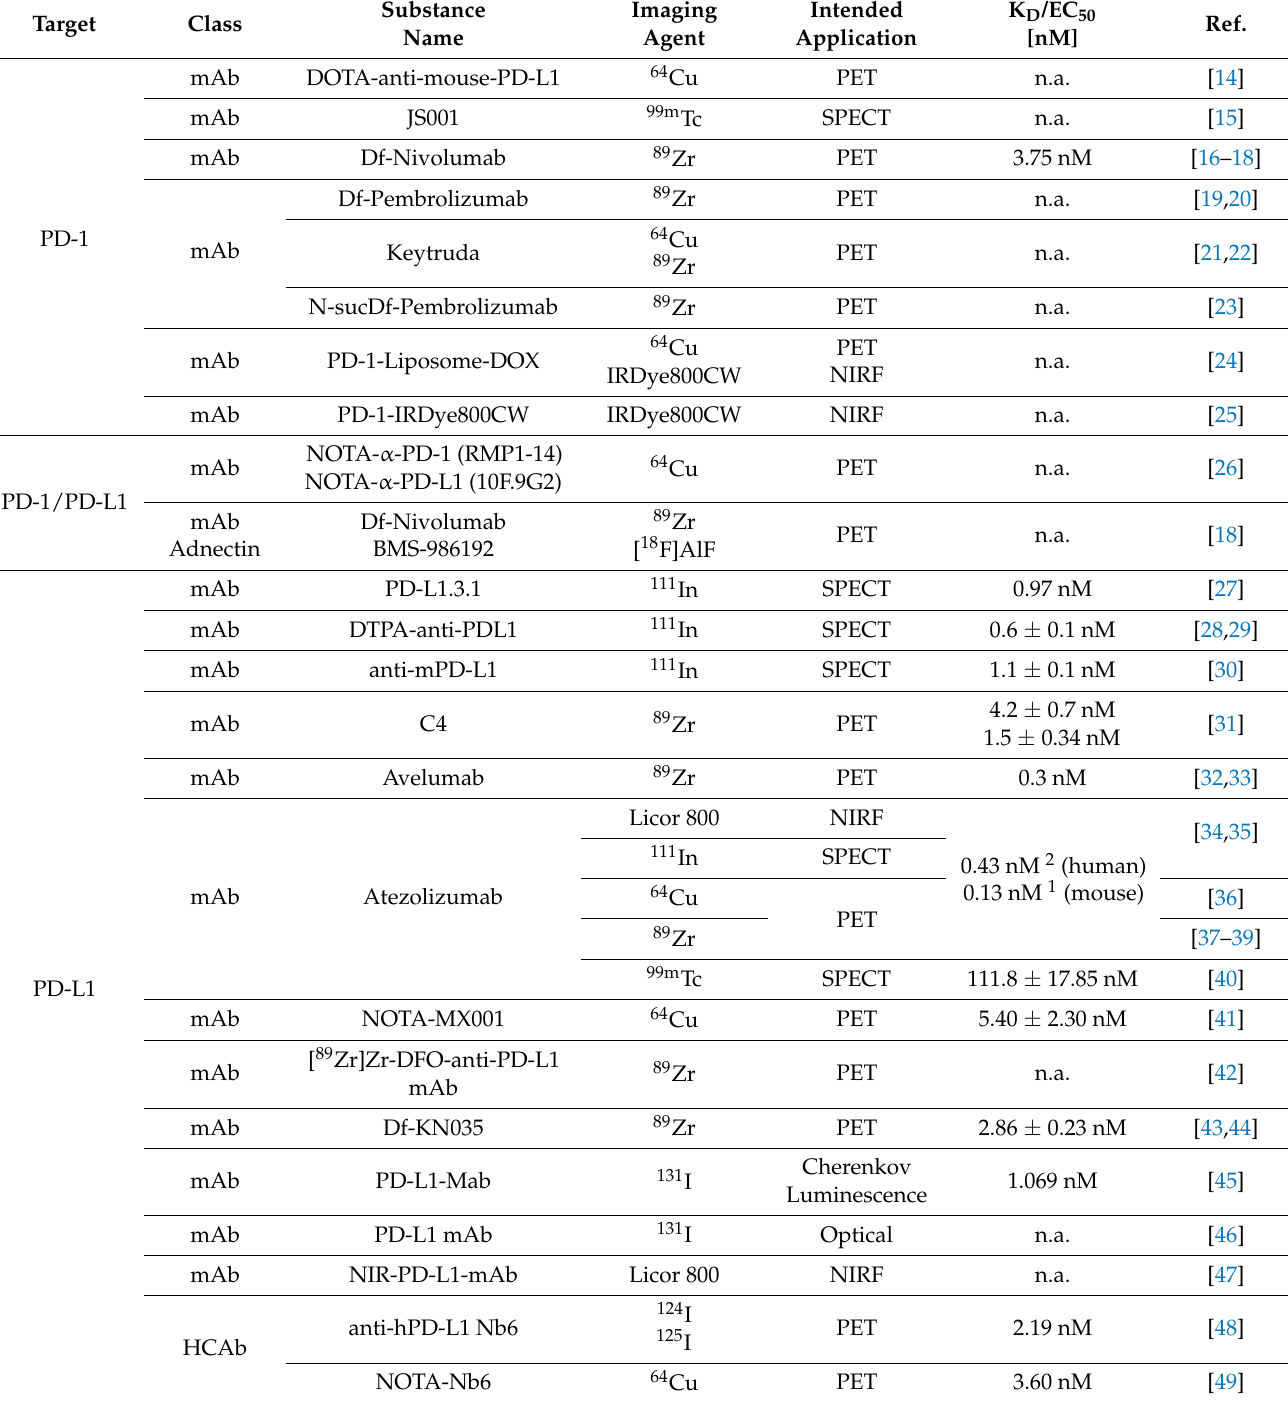
Table 1. Overview imaging agents addressing PD-1 and PD-L1 classified by substance name, imaging agent, intended application, and binding affinity (K D /EC 50